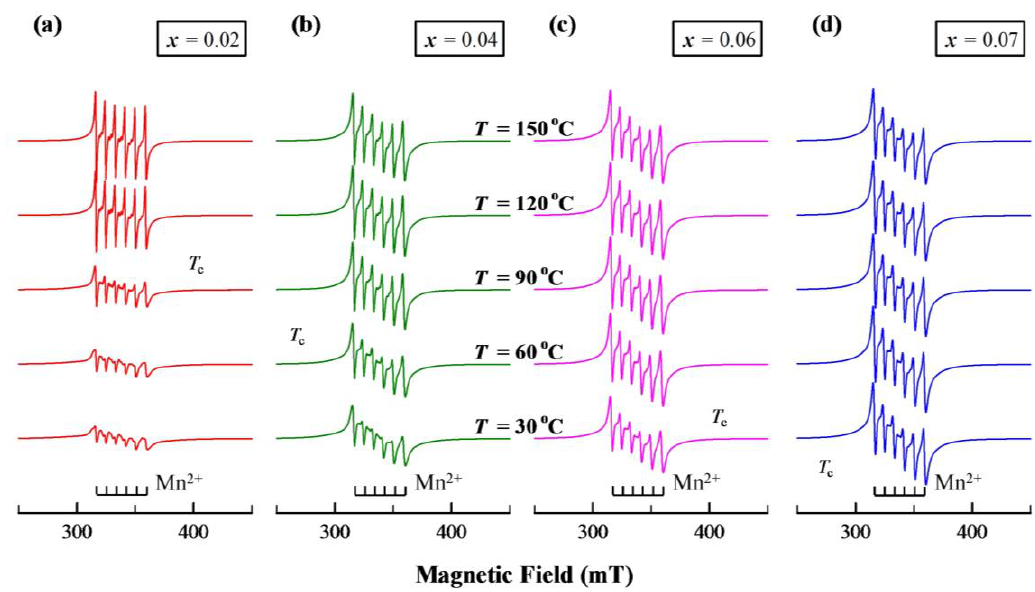
Figure 7. Electron paramagnetic resonance (EPR) spectra of BSTM ceramics with ( a ) x = 0.02, ( b ) x = 0.04, ( c ) x = 0.06, and ( d ) x = 0.07 at different temperatures.